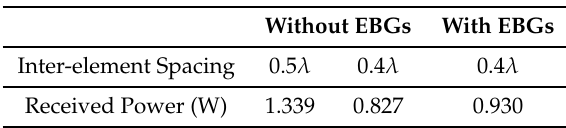
Table 1. Comparison of the received power when using the 10 × 10 CP RDAs with and without the EBGs (where λ is free space wavelength at the designed frequency of 5.2 GHz).